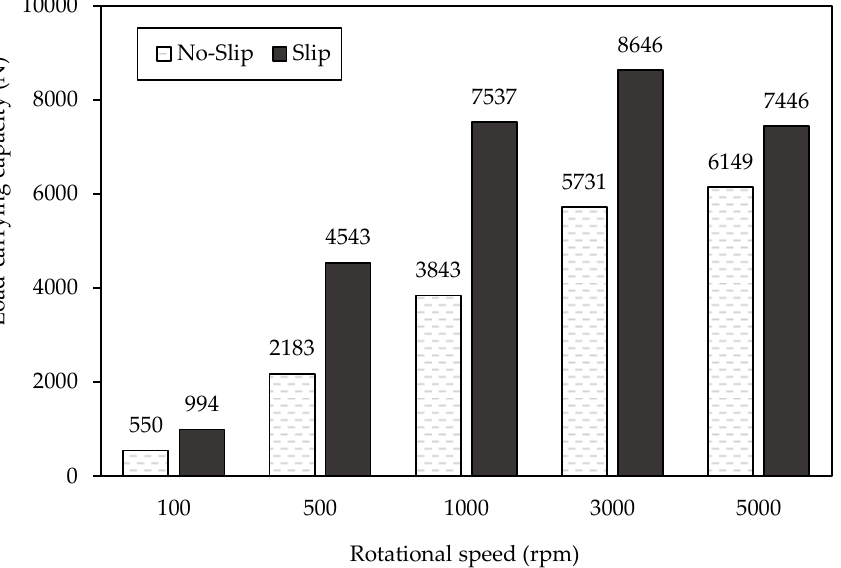
Figure 8. Comparison of the load-carrying capacity between the conventional (no-slip) bearing and the heterogeneous slip/no-slip bearing at different rotational speeds. All results are evaluated at z / L = 0.5.